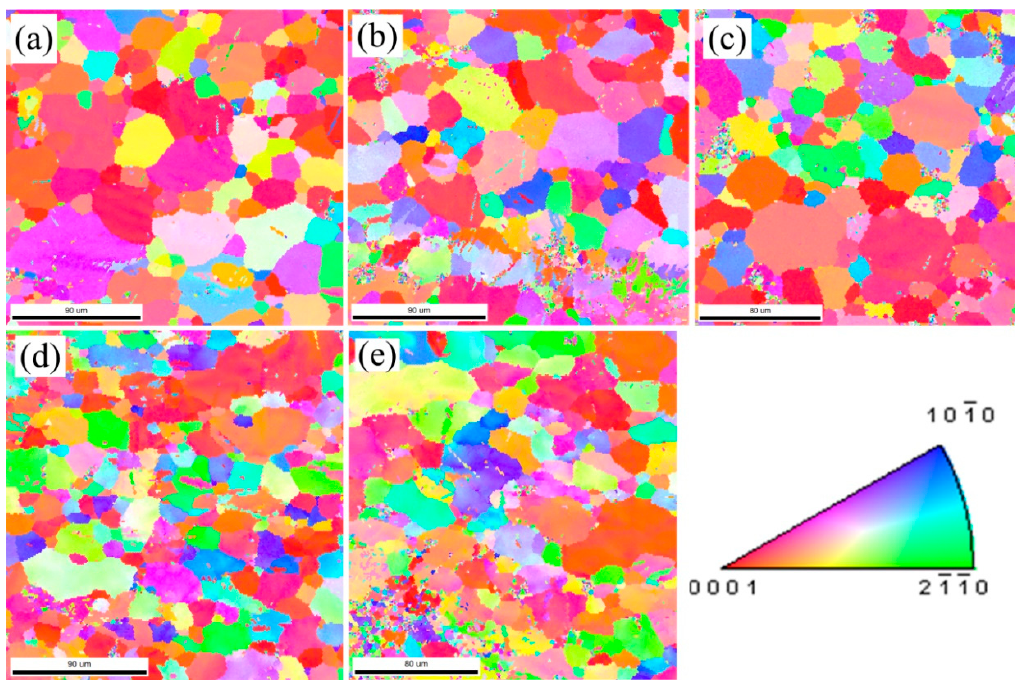
Figure 4. Colored IPF maps obtained from EBSD analysis in ND near the fracture areas of the failure samples for the different tested configurations: ( a ) undeformed material, ( b ) RT, ( c ) OH, ( d ) AC, and ( e ) EA and the color pallet associated to the Miller indices.